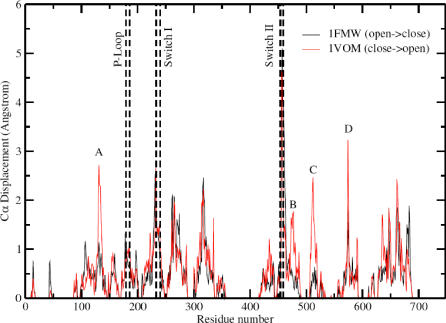
Displacements of the Cα Atoms in the PMF Simulations of the 1FMW:ATP and 1VOM:ATP States, Relative to the Corresponding X-ray StructureThe structures are taken as the last snapshot from PMF simulations at ΔDmin = 2.2 Å, or at ΔDmin = −2.2 Å. Region A, the C-terminal of the second central ß sheet; Region B, the loop between the N-terminal of the relay helix and Switch II; Regions C and D, the actin-binding clefts.